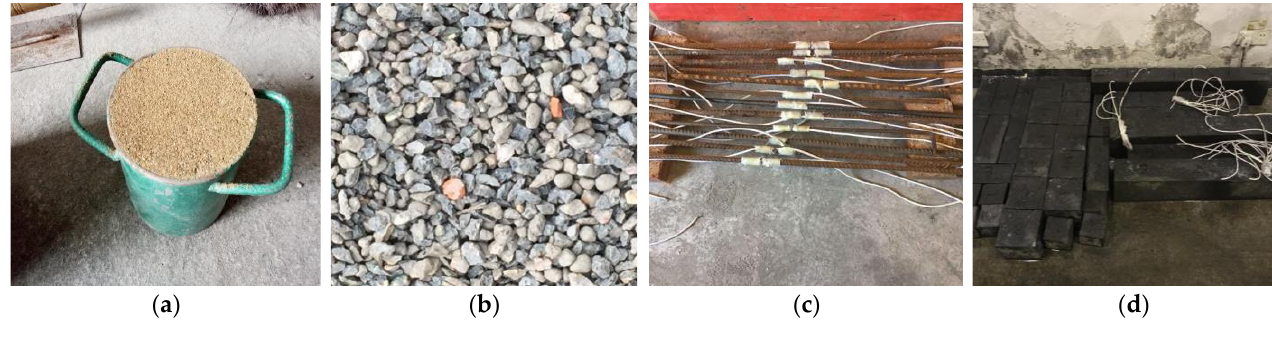
Figure 1. Fine aggregate, recycled coarse aggregate, reinforcement bar, and specimens. ( a ) The fine aggregate; ( b ) The recycled coarse aggregate; ( c ) HRB400 ribbed steel bars; ( d ) Block and beam specimens. Table 1. Tested parameters of fine aggregate. Table 1. Tested parameters of fine aggregate.